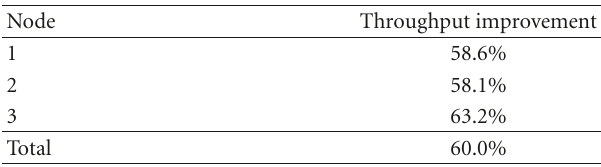
Figure 9: Matlab linear program gain results, accounting for over- head. Top: 2 channels available. Bottom: single channel available. Table 3: NS2 Throughput Improvements for scenario shown in Figure